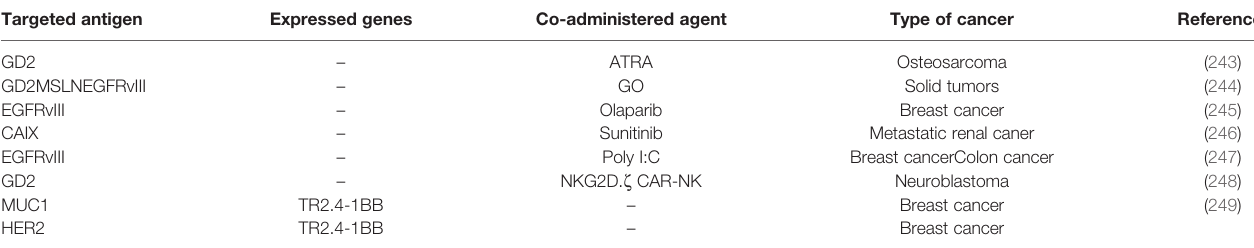
TABLE 7 | Summary of preclinical studies on CAR-T cells strategies counteracting the immunosuppressive effect of MDSCs. Targeted antigen Expressed